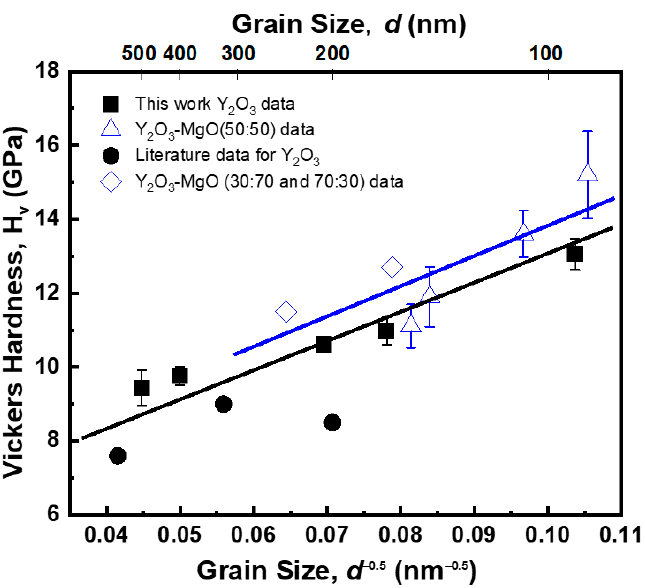
Figure 11. Hall-Petch plot of the Y 2 O 3 with the data from this work and literatures [26] and the plot of Y 2 O 3 -MgO nanocomposites with data reported in our previous works. [34,43]. In contrast to the hardness, the fracture toughness K IC in Figure 12 takes almost the similar value ranging from 1.1 ± 0.08 to 1.43 ± 0.19 MPa · m 1/2 and the effect of grain size is